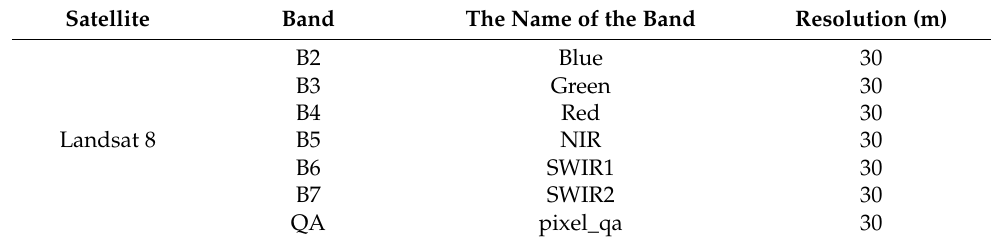
Table 4. Landsat image band parameters.